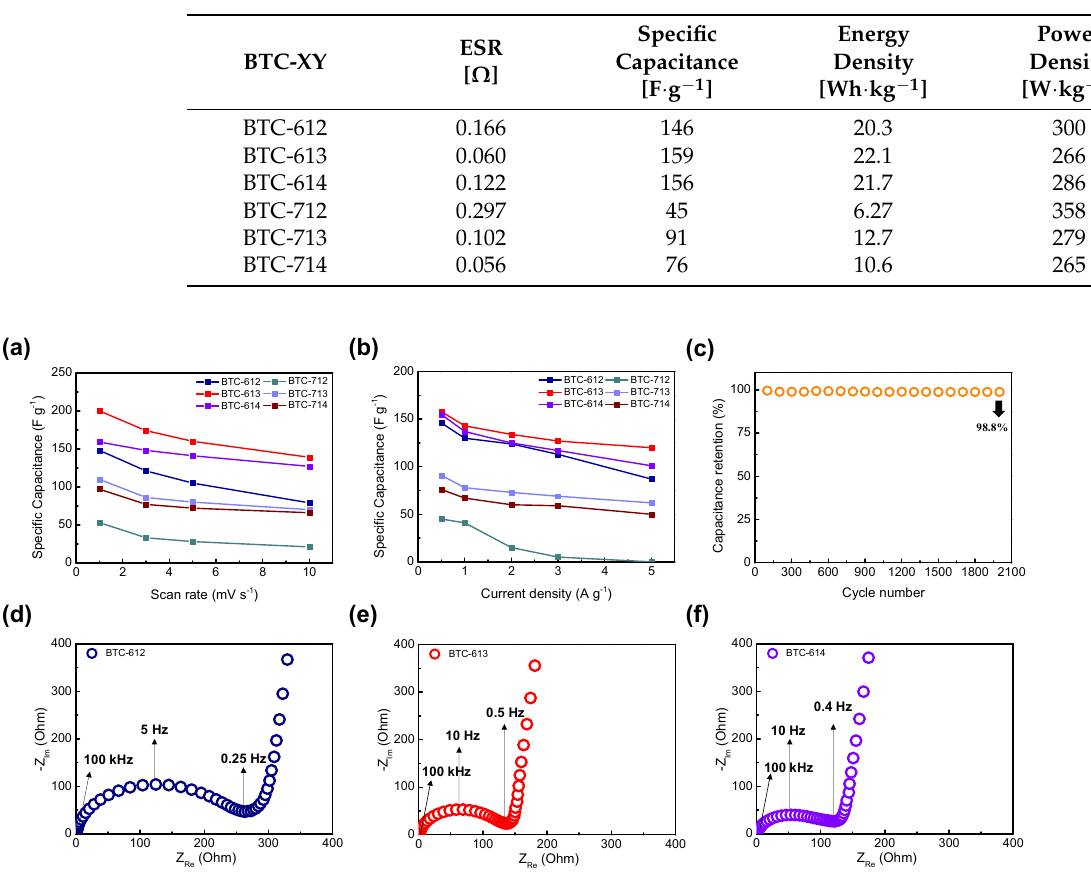
Figure 9. ( a ) Specific capacitance of BTCs at various scan rates ranging from 1 to 10 mV · s − 1 , ( b ) specific capacitance of BTCs at various current densities from 0.5 to 5 A · g − 1 , ( c ) capacitance retention of BTC-613 electrode over 2000 cycles at a current density of 5 A · g − 1 . ( d ) ElS plot of BTC-612, ( e ) BTC-613, ( f ) ElS plot of BTC-614.